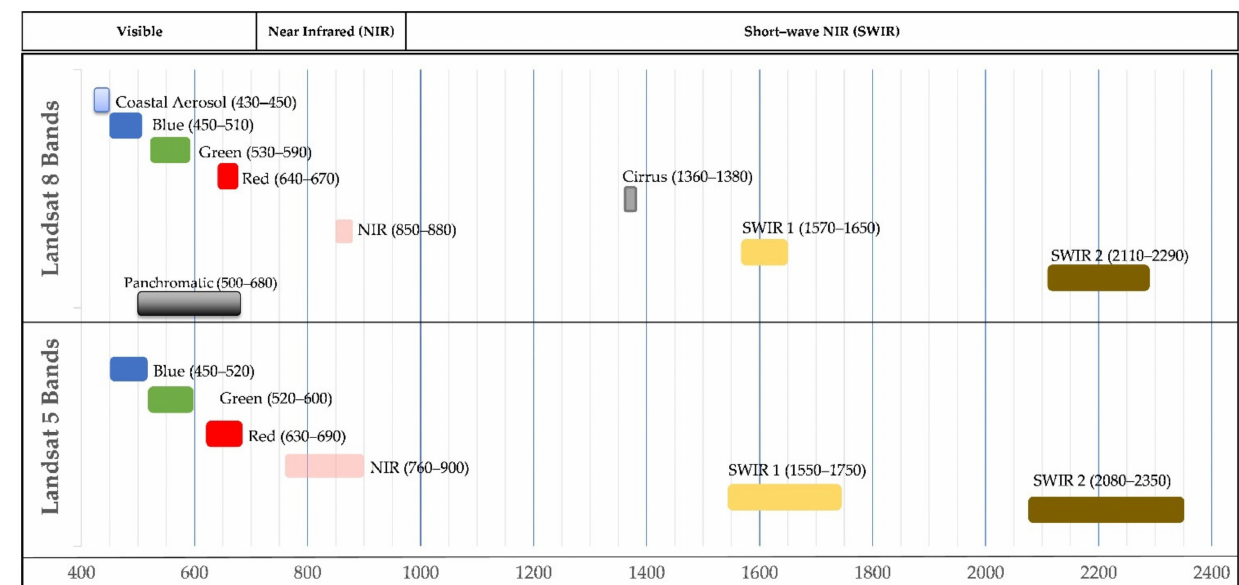
Figure 4. Comparison of Landsat 5 and 8 bands and their wavelengths